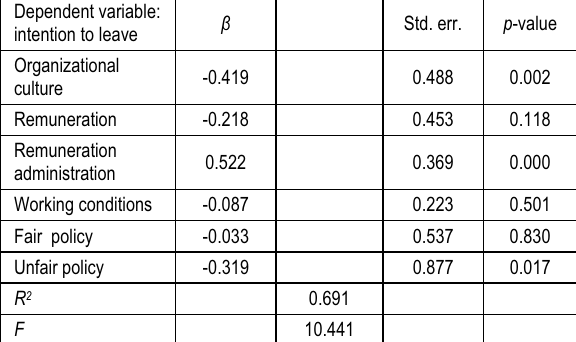
Table 4. Regression of human resource